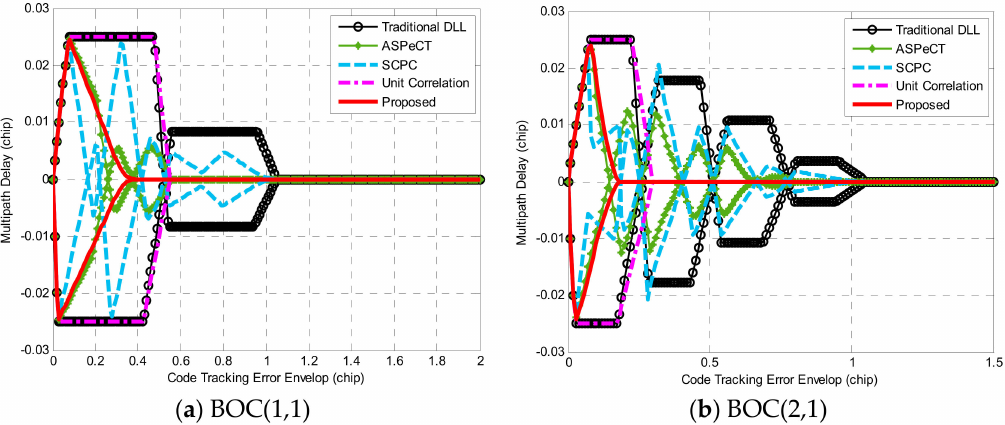
Figure 19. Comparison of the multipath error envelope (MEE)